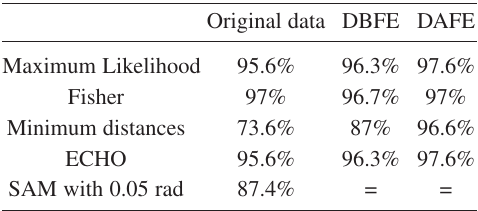
Table II. Overall accuracy values for the test area in fig.